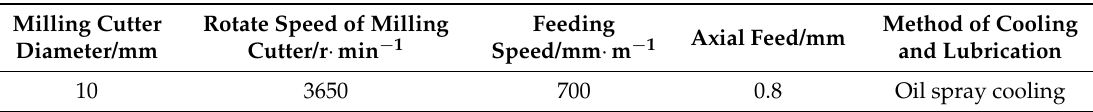
Table 2. Machining parameters in the milling process.